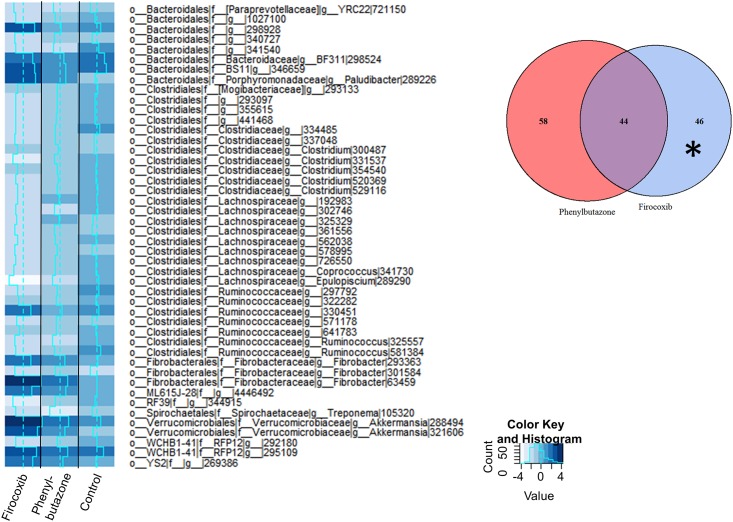
The directionality of the DE OTUs unique to the firocoxib group is mirrored in the phenylbutazone group and these OTUs represent similar families of bacteria albeit with different OTU assignment.Heatmap showing log2 fold-change of DE OTUs in firocoxib-treated horses only (left column) after 10 days of administration. The log2 fol change of these same OTUs are shown for phenylbutazone-treated (middle column) and control (right column) horses for comparison although these OTUs were not DE in these groups. Dashed line in center of each heatmap column represents log2 fold change of 0 (i.e., no fold change), solid line represents mean log2 fold change specific to each OTU within each treatment group. Asterisk in Venn diagram (inset) visually depicts the source of the 46 OTUs represented in this heatmap.